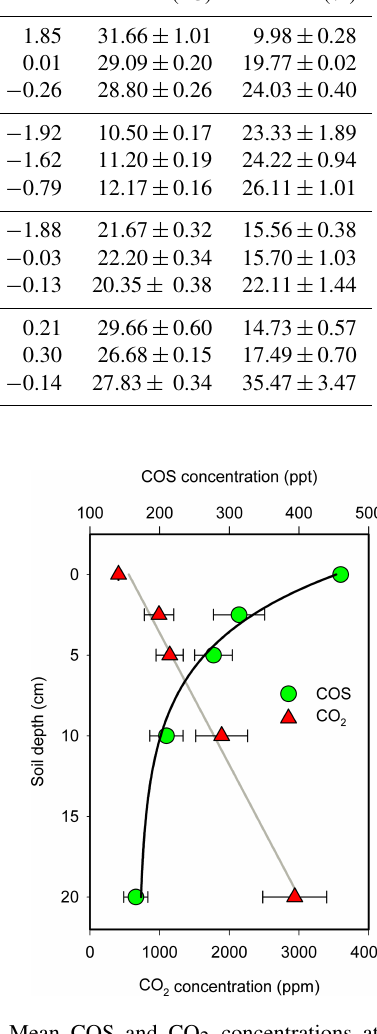
Figure 4. Mean COS and CO 2 concentrations at different soil depths. The COS concentration decreases exponentially with soil depth. The data point is the mean of the combined data at each of the four measurement campaigns ( N = 4; ± 1